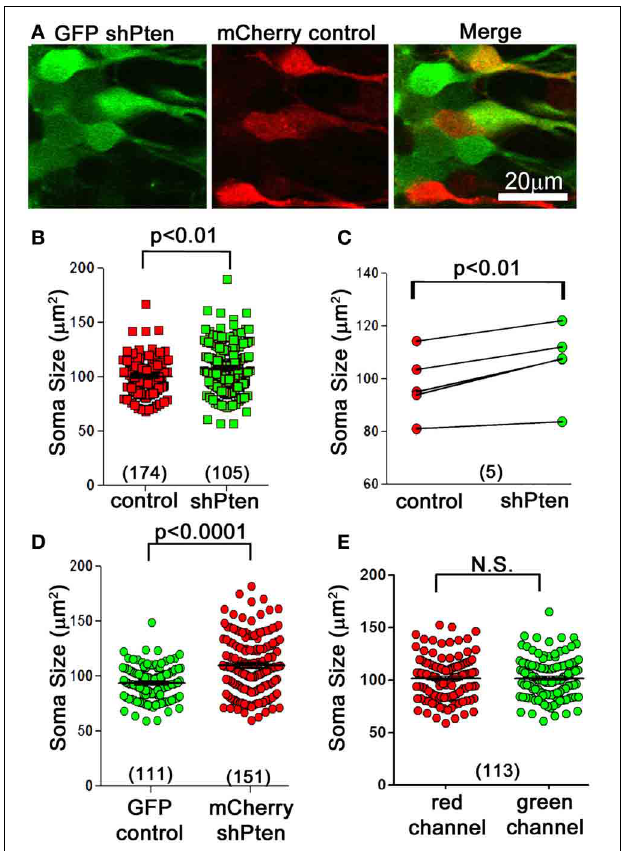
FIGURE 1 | Neuronal hypertrophy in lentiviral Pten knockdown neurons. A lentivirus to knock down Pten (GFP shPten; green) and a control lentivirus (mCherry control; red) were co-injected into the dentate gyrus of young adult mice and the morphological results assessed at 21 days post-injection. (A) We observed an increase in soma size in Pten knockdown neurons (green) compared to controls (red). (B) Plot of soma cross-sectional area of individual control and Pten knockdown neurons. (C) Cross-sectional area of control and knockdown neurons plotted as an average per animal. Quantitative analysis of soma cross-sectional area from confocal image stacks revealed that Pten knockdown results in an increase in soma size (108.1 ± 1.66 µ m 2 compared to 100 ± 1.75 µ m 2 in the control; p < 0 . 01, n = 174 and 105 neurons from 5 animals). (D) Pten knockdown resulted in an increase in soma size regardless of flourophores. Mice were co-injected with mCherry shPten and GFP control viruses, and there was a significant increase in the soma size of mCherry shPten infected neurons compared to GFP infected controls (GFP control = 95.19 ± 1.47 µ m 2 , mCherry shPten = 110.9 ± 2.19 µ m 2 , p < 0 . 0001, two-tailed t -test, n = 111 neurons and 151 neurons from 2 animals). (E) There was no difference in soma size when the same co-labeled neurons were analyzed in the red or green channel (soma size in red channel = 101.8 ± 1.94 µ m 2 , average soma size in green channel = 101.8 ± 1.85 µ m 2 , p > 0 . 05, two-tailed t -test, n = 113 neurons from 3